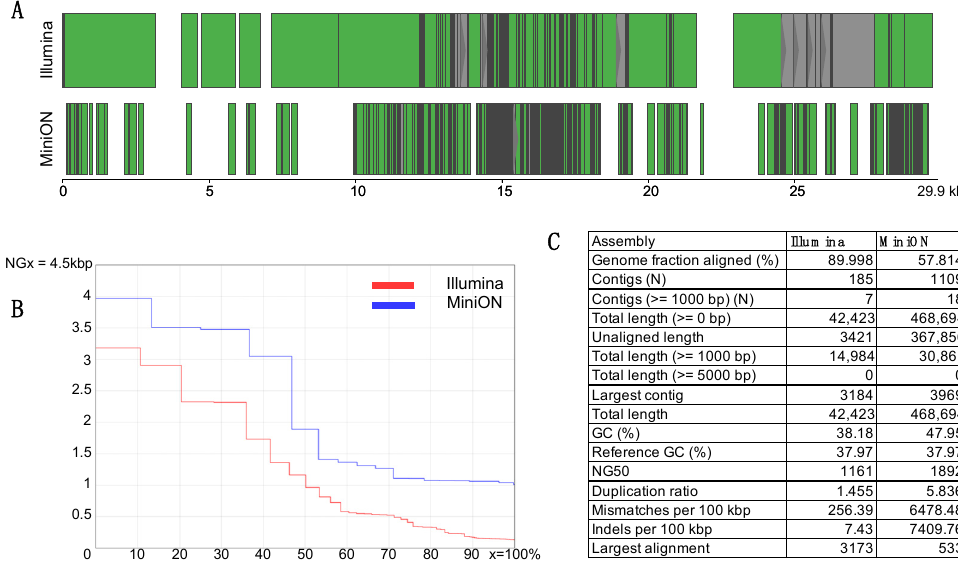
Figure 3. Comparison of SARS-CoV-2 de novo assemblies from Illumina and MinION target enriched libraries. ( A ) Alignment of Illumina (top) and MinION (bottom) contigs on the SARS-CoV-2 genomic map. Green contigs represent concordant alignments, while grey contigs represent discordant alignments. ( B ) Comparison of the NGx metric for Illumina (red) and MinION (blue) assemblies. ( C ) Comparative metrics of size and error profiles for both assemblies.